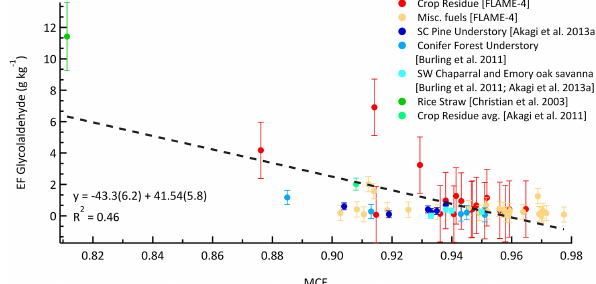
Figure 12. Glycolaldehyde EFs as a function of MCE shown for current FLAME-4 CR, all remaining FLAME-4 fuels, a series of airborne measurements from US field campaigns, and laboratory rice straw measurements, with error bars representing one standard deviation of the EF where